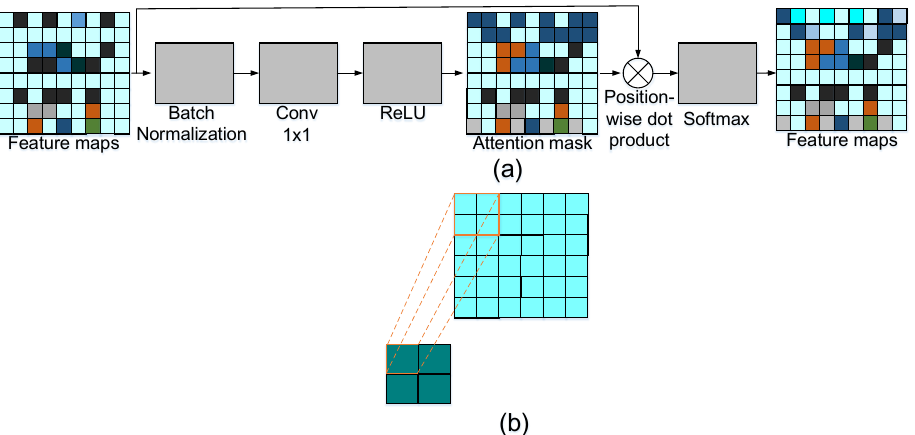
Figure 8. Attention pooling module; ( a ) the principle of attention weight; ( b ) the principle of pooling